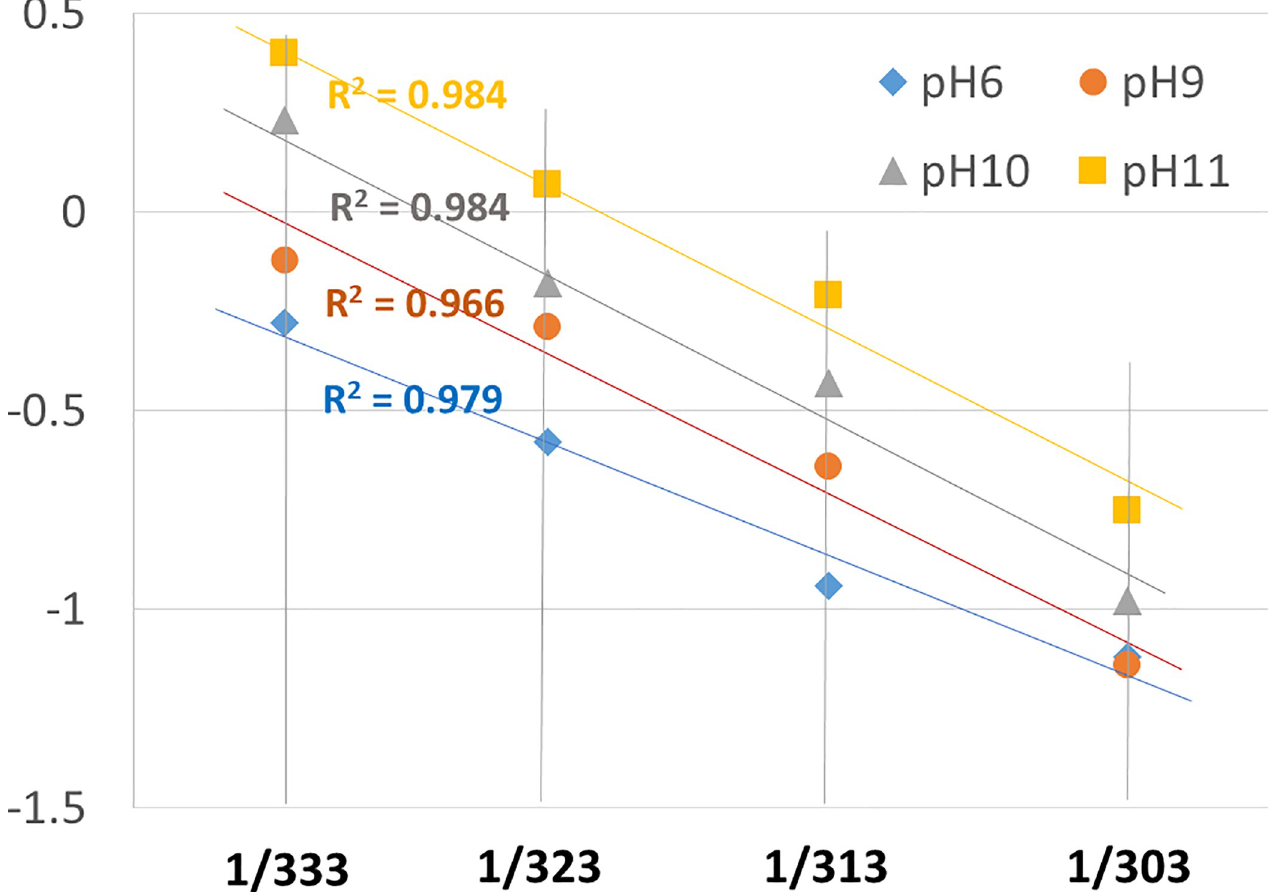
Fig 4. The relationship between μ rl and 1/ T obtained from the washing test with respect to various pH and temperature levels.